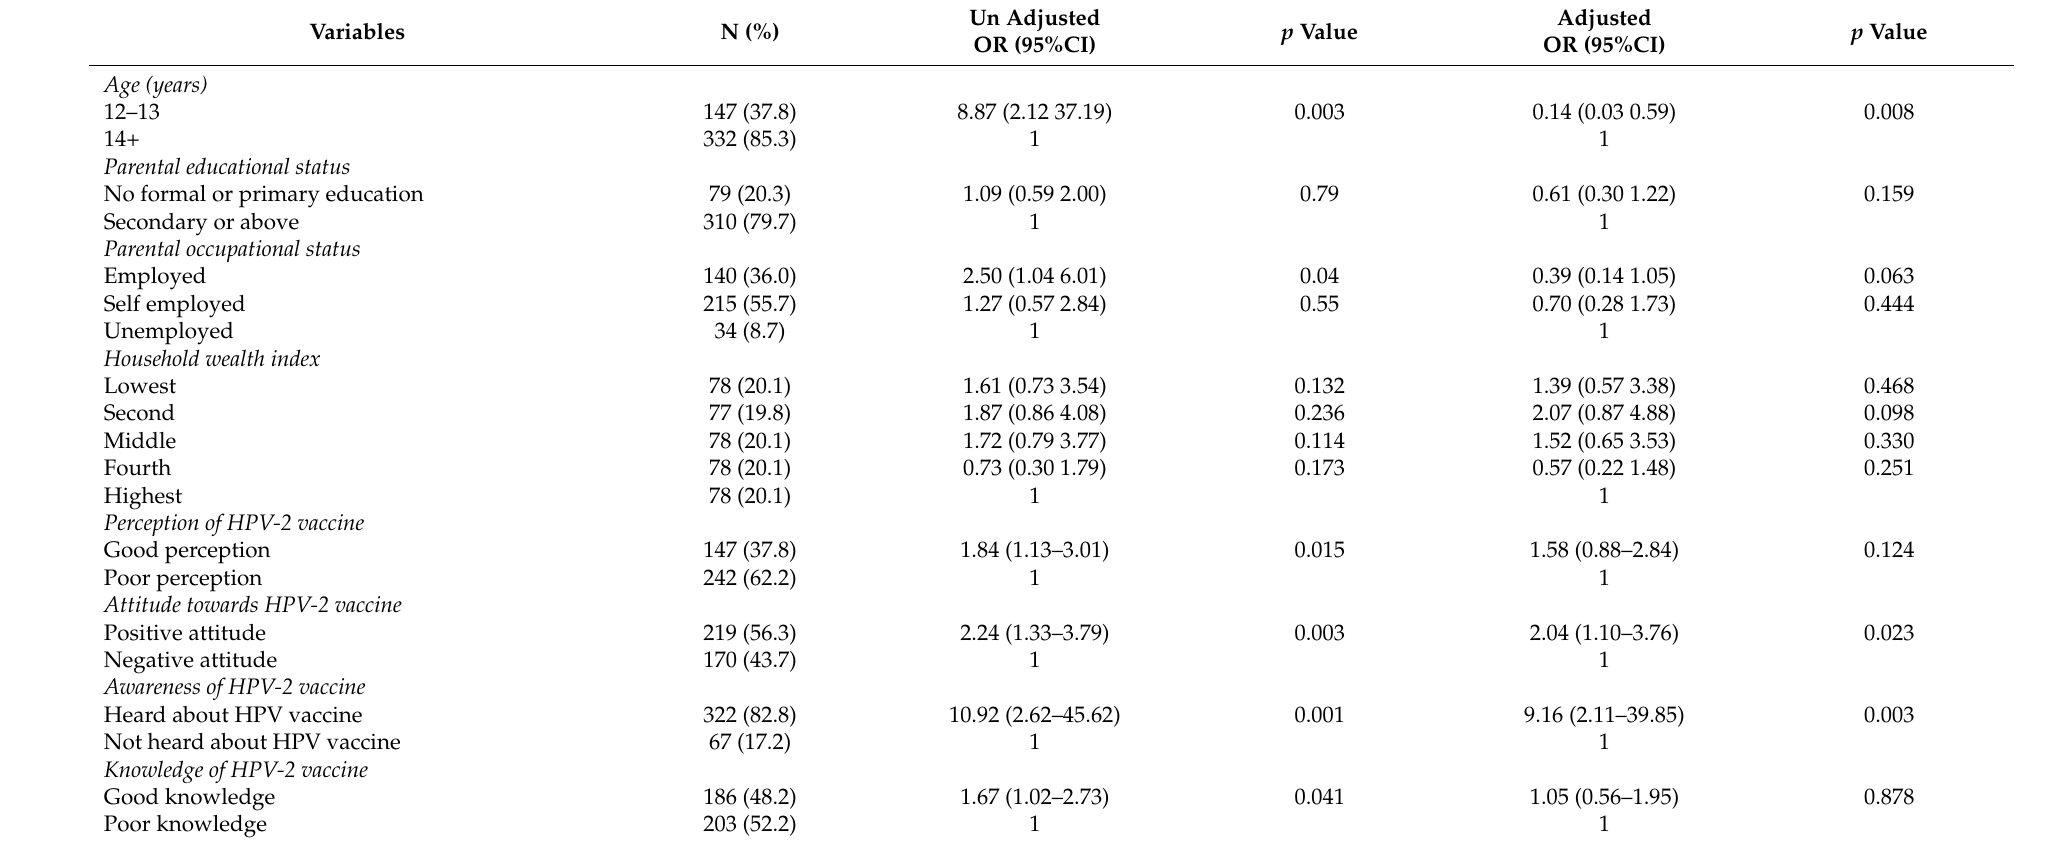
Table 2. Logistic regression for the factors associated with HPV-2 uptake